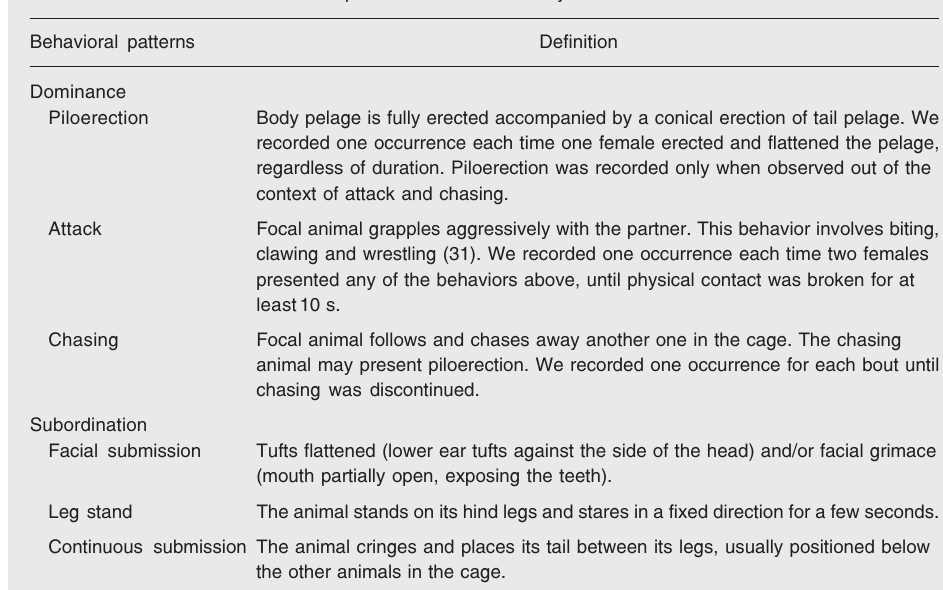
Table 1. Definitions of the behavioral patterns used in this